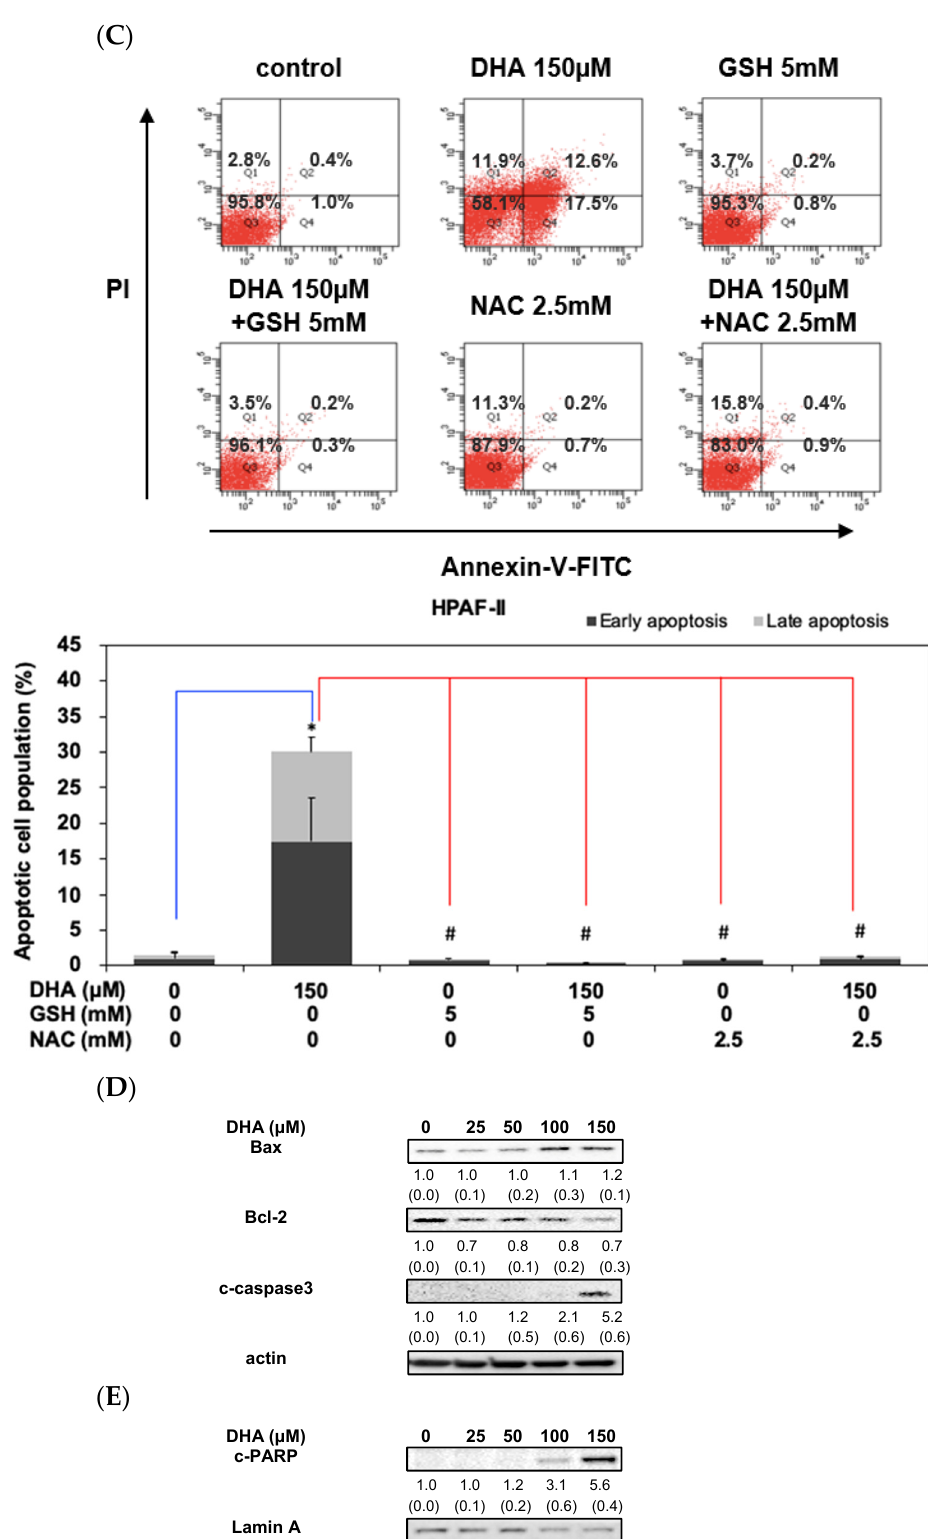
Figure 5. DHA inhibited cell survival through an induction of apoptosis in HPAF-II cells. Human PDAC HPAF-II cells were untreated or treated with DHA in 10% FBS DMEM for 24 hr. H 2 O 2 was used as a positive control(Supplementary Figure S1). ( A ) Analysis of cell apoptosis levels were performed using flow cytometry as described in Materials and Methods Section. The quantitative re- sults of cellular apoptosis population were presented in the bottom panel. An asterisk (*) represent